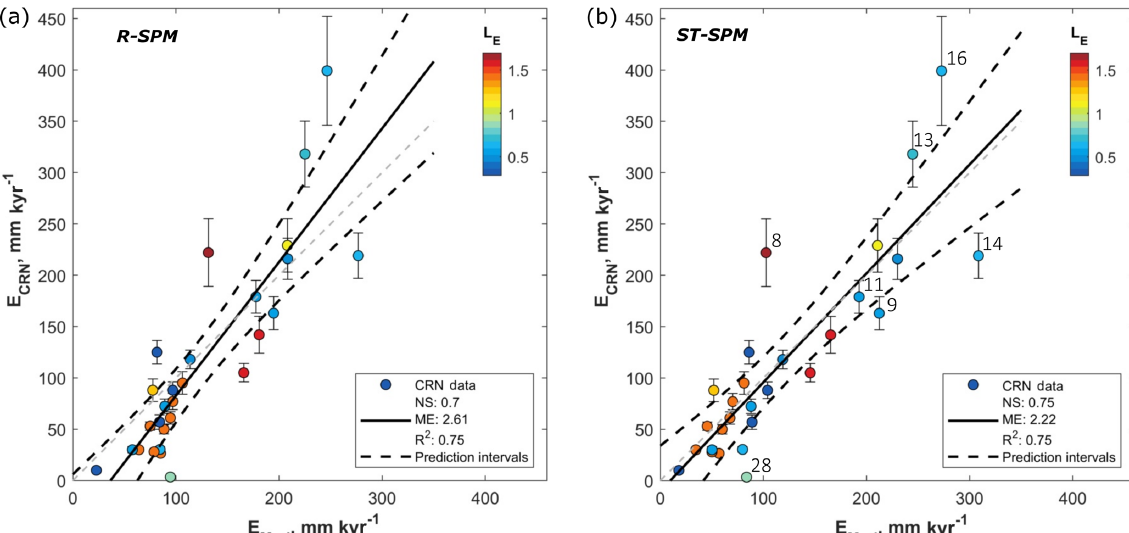
Figure 8. Best fit between CRN-derived erosion rates ( E CRN ) and modeled river incision ( E Mod ) using the Runoff-Based and Stochastic- Threshold Stream Power Model. (a) R-SPM scenario 2 (Table 4) using the average lithological erodibility ( L E ) and runoff R values per sub-catchment (both listed in Table 2). (b) ST-SPM scenario 7 (Table 4) using the average lithological erodibility ( L E ) and runoff ( R ) values, as well as an incision threshold ( τ c = 14Pa). Numbered observations in (b) correspond to catchment IDs as listed in Table 2 (see also the discussion in Sect. 5). A complete overview of all best model fits for R-SPM scenarios 1–2 and ST-SPM scenarios 1–8 is given in Figs. S9 and S10,